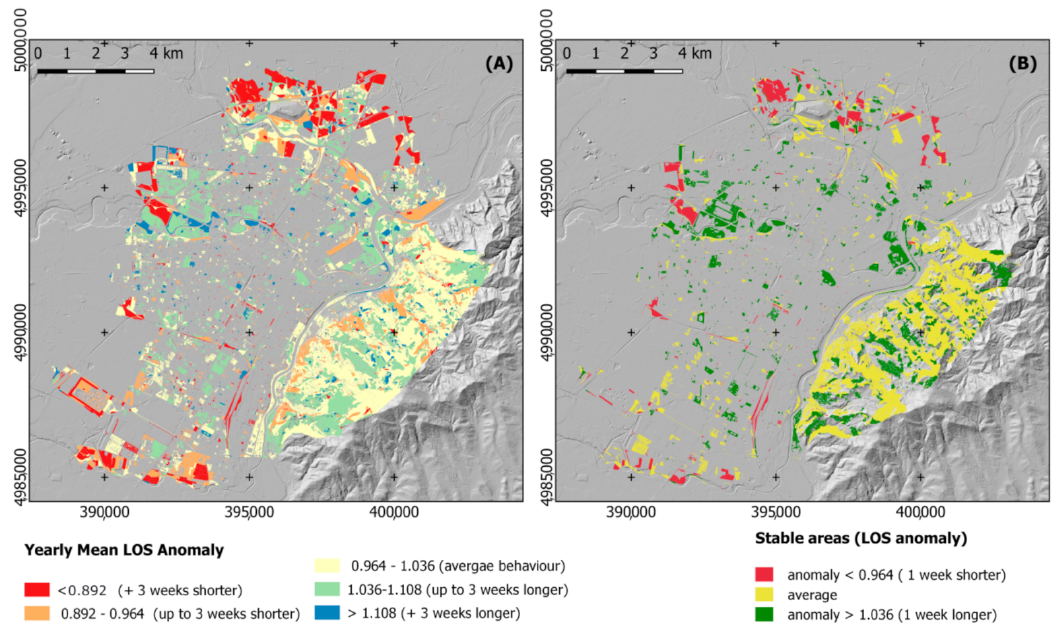
Figure 5. ( A ) Spatial distribution of the 3-year average LOS anomaly over Torino. The anomaly is computed according to Equation (2). Five classes were mapped: one mapping areas showing an average LOS value more than 3 weeks shorter than the average one (<0.892); one mapping areas showing an average LOS value up to 3 weeks shorter than the average one (0.892–0.964); one mapping areas showing a LOS value (0.964–1.036) comprised in the range average LOS ± 1 week; one mapping areas showing an average LOS value up to 3 weeks longer than the average one (1.036–1.108); and one mapping areas showing an average LOS value more than 3 weeks longer than the average one (>1.108). ( B ) Map showing areas that, in the three investigated years, always behaved similarly in term of LOS anomaly (averagely shorter, equal or longer then yearly mean LOS of the area). Reference